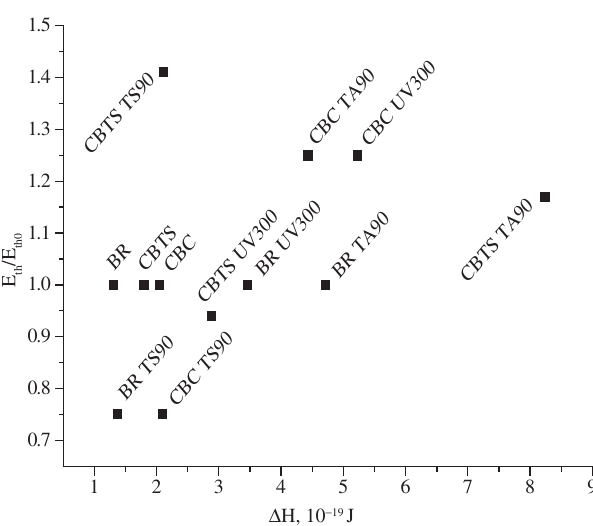
Figure 10. The Eth/Etho vs. ∆ H plot for all the samples, before and after ageing